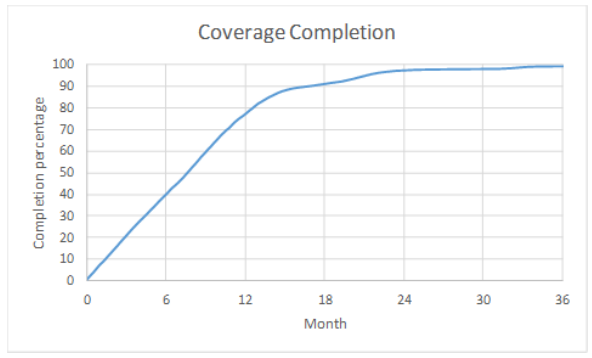
Figure 8. Arc of Interest coverage completion